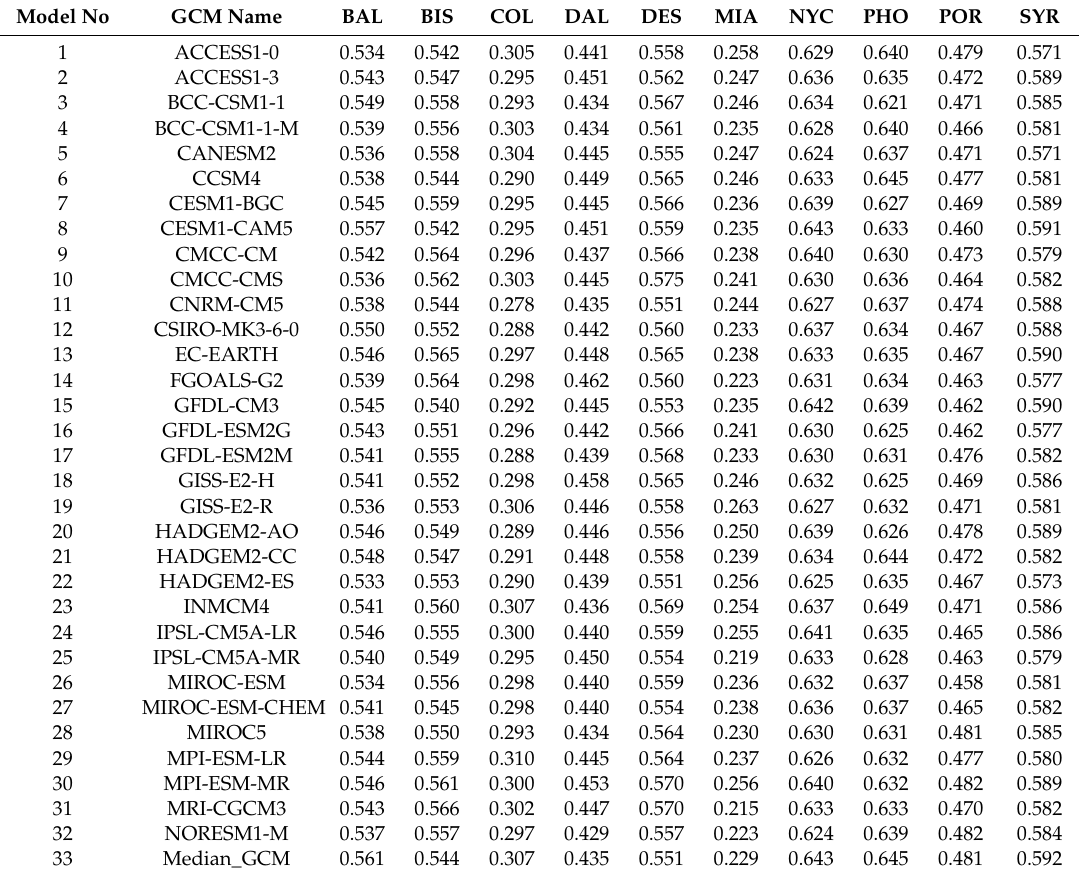
Table A3. NSE coe ffi cient of maximum temperature between observed and simulated data (1950–2005). Model